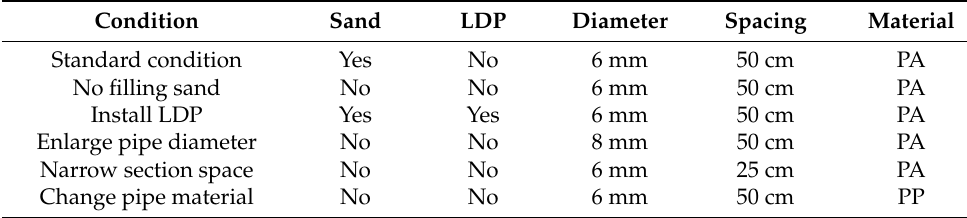
Table 1. Indoor test conditions of tunnel drainage pipe